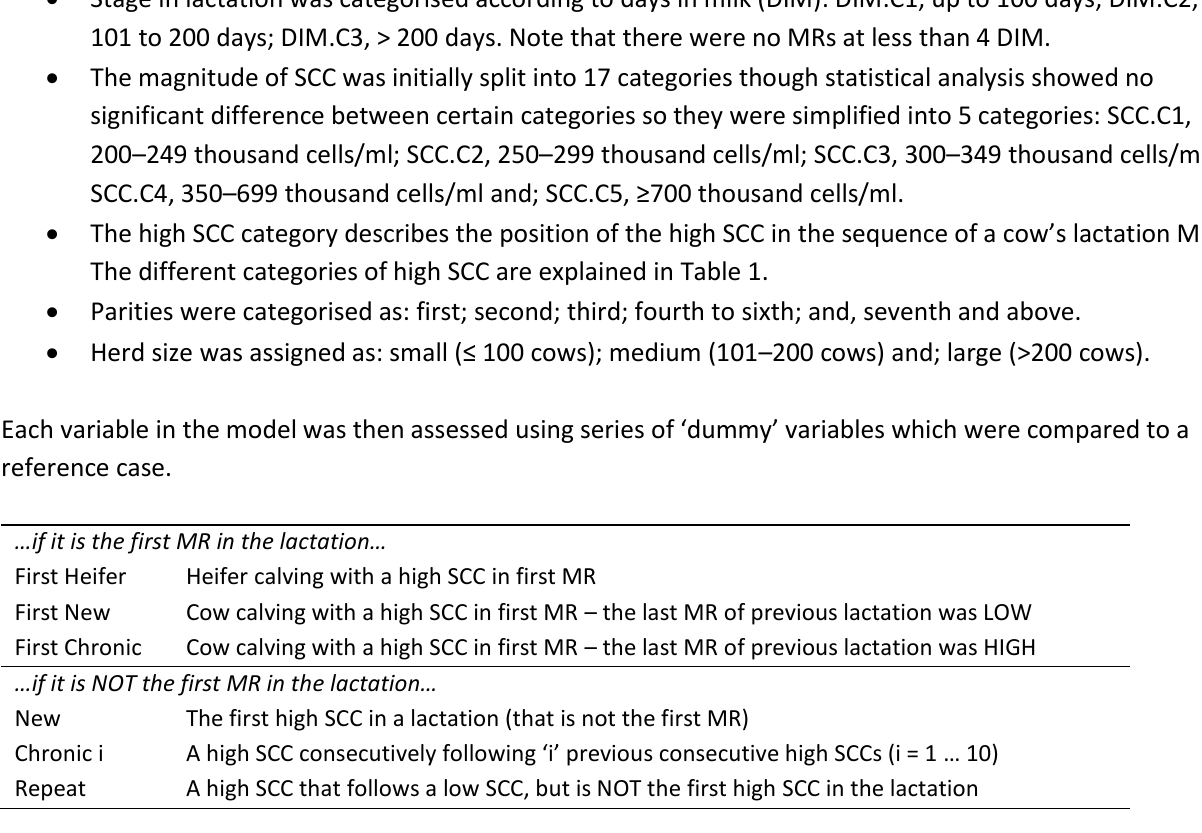
Table 1: categories of High SCC and